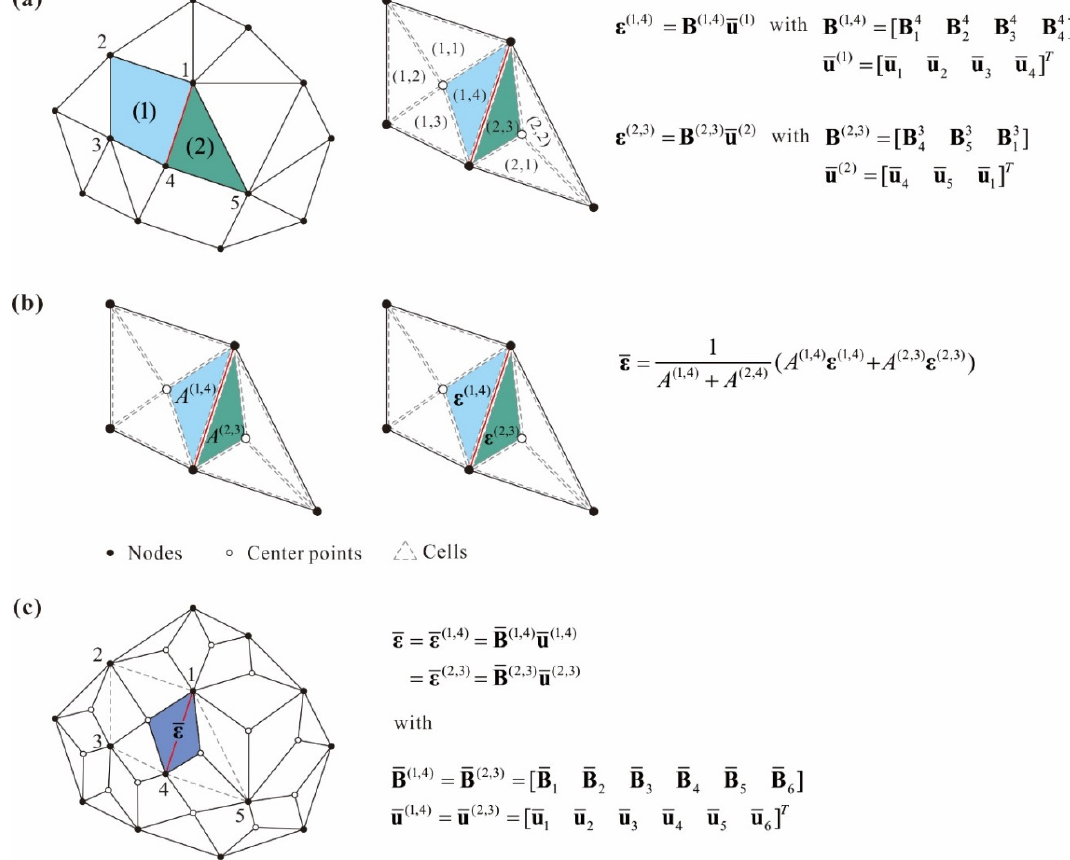
Figure 2. Strain smoothing domain for the edge-based smoothed element: ( a ) Finite element mesh. The red line corresponds to a target edge. ( b ) The elements are divided into cells. ( c ) Smoothing domains of the edge-based smoothed element and the smoothed strain in the smoothing domain.